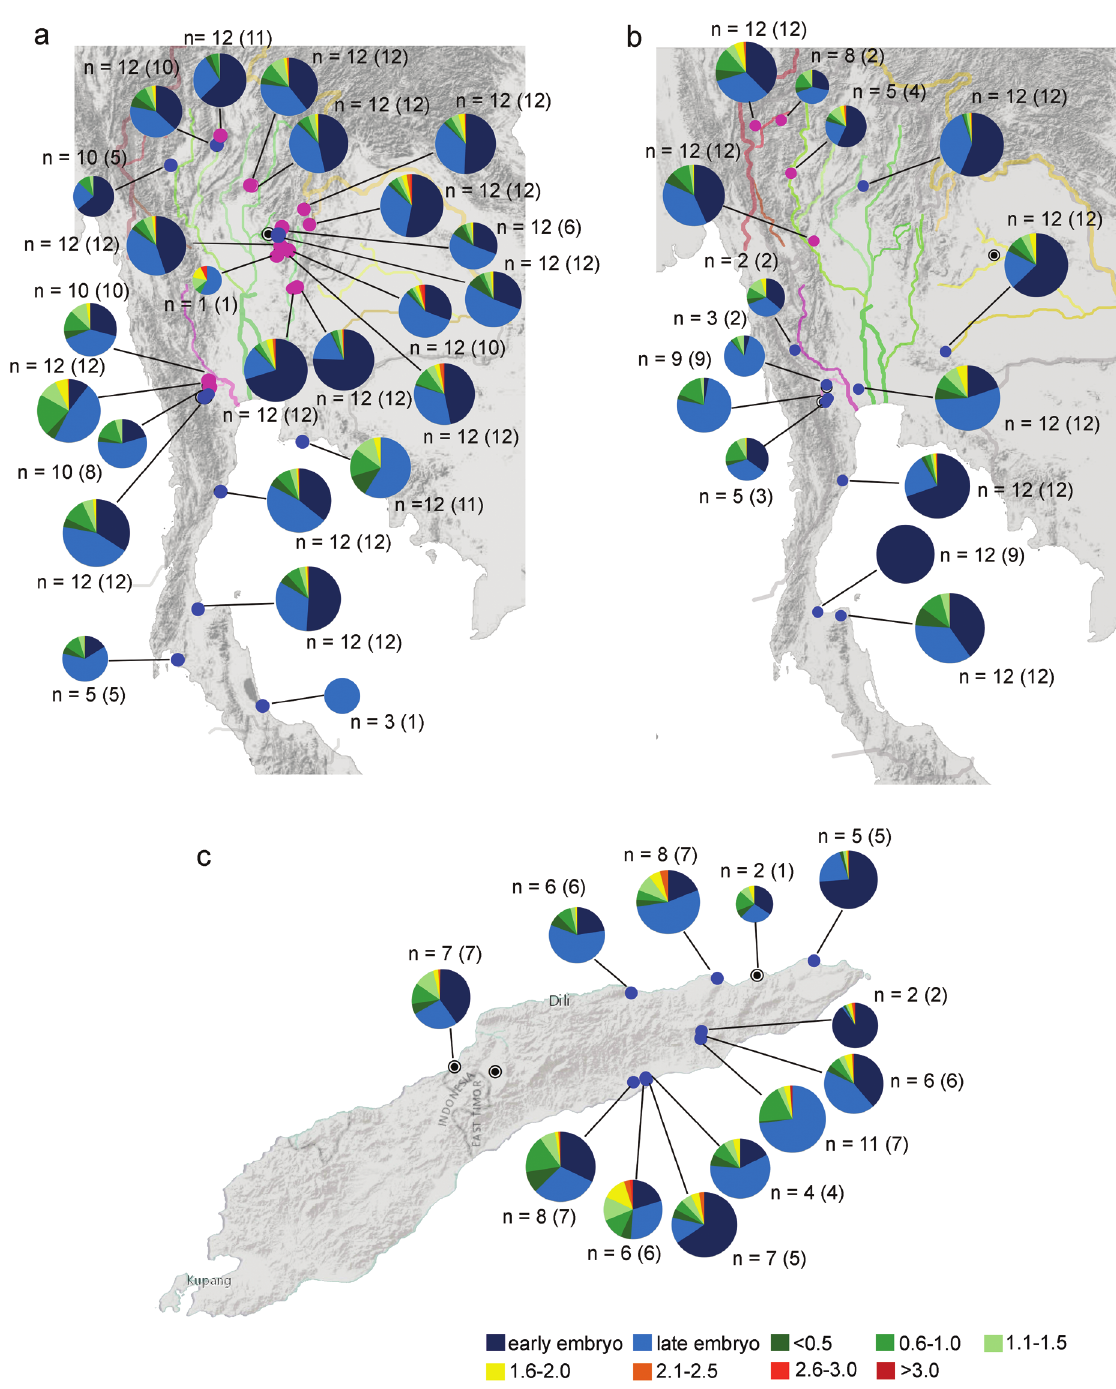
Figure 9. Frequency of ontogenetic stages in the subhemocoelic brood pouches of female Tarebia granifera (Lamarck, 1816) de- pending on occurrence in Thailand and Timor Leste. a . Morph A in Thailand; b . Morph C in Thailand; c . Timor Leste. Blue dots: mitochondrial clade A; pink dots: mitochondrial clade B. Size classes are assigned different colours in the pie charts (see legend) and rivers are coloured according to drainage systems; numbers at the pie charts refer to the total number of dissected specimens and the number of gravid females (in